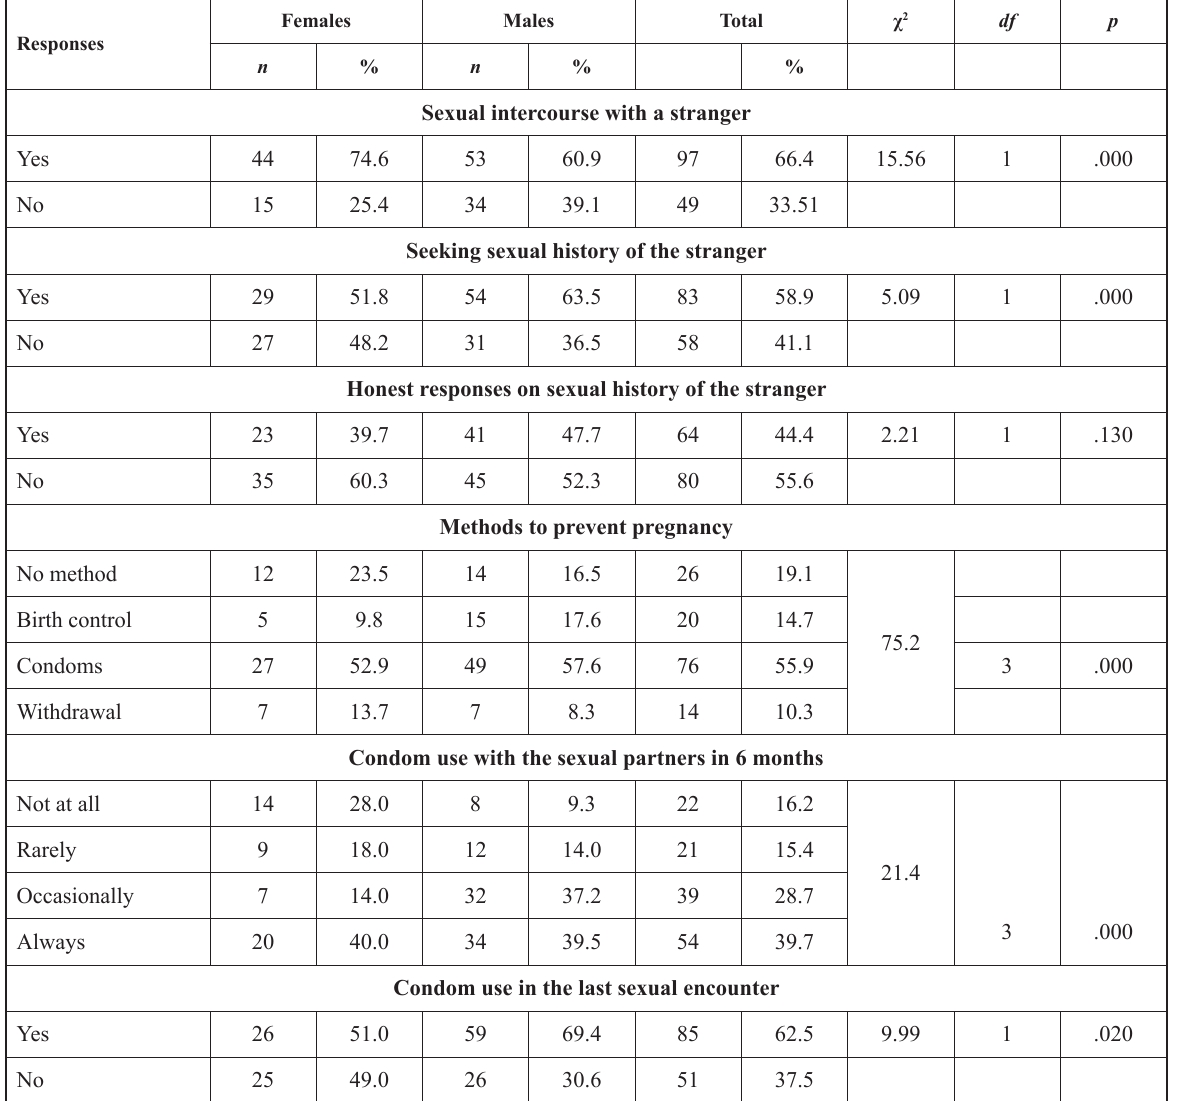
Table 4. Sexual history with strangers and prevention of pregnancies